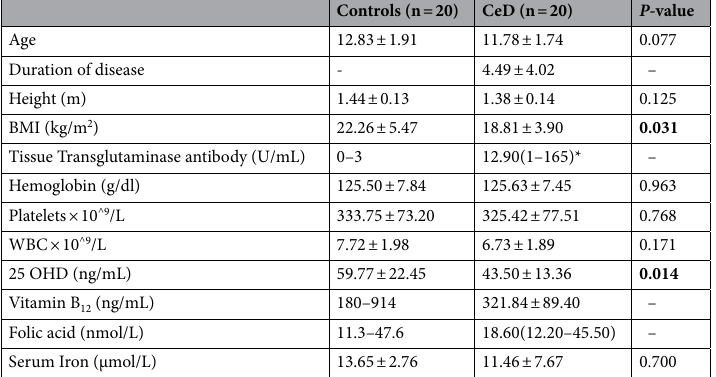
Table 1. Clinical demographic and laboratory measures in control subjects and children with CeD. Data is presented as mean ± SD or median (range), Anti TtG, vitamin B12 and folic acid levels were compared with the normal laboratory range. CeD: Celiac Disease, BMI: Body Mass Index, WBC: White blood Cell Count. *Anti-TtG was available in 12/20 children with CD. Significant differences between groups are highlighted in bold.